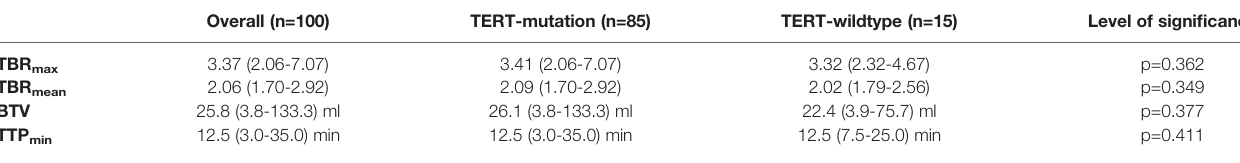
TABLE 1 | In fl uence of TERT-mutation on 18 F-FET-uptake characteristics [median (range)]. Overall (n=100)